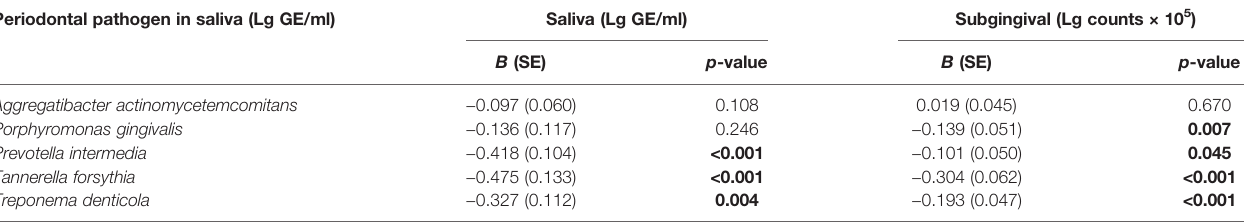
TABLE 4 | Association of saliva and subgingival concentrations of periodontal bacteria and number of prescribed antibiotics within a year. Periodontal pathogen in saliva (Lg GE/ml)